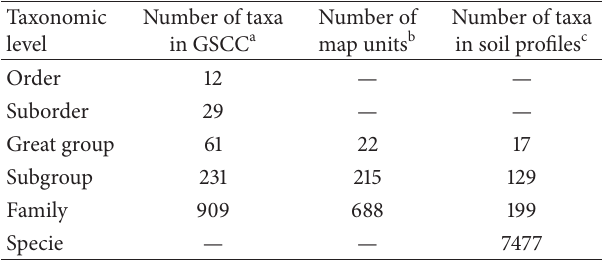
Table 1: Number of taxa or map units at taxonomic levels in